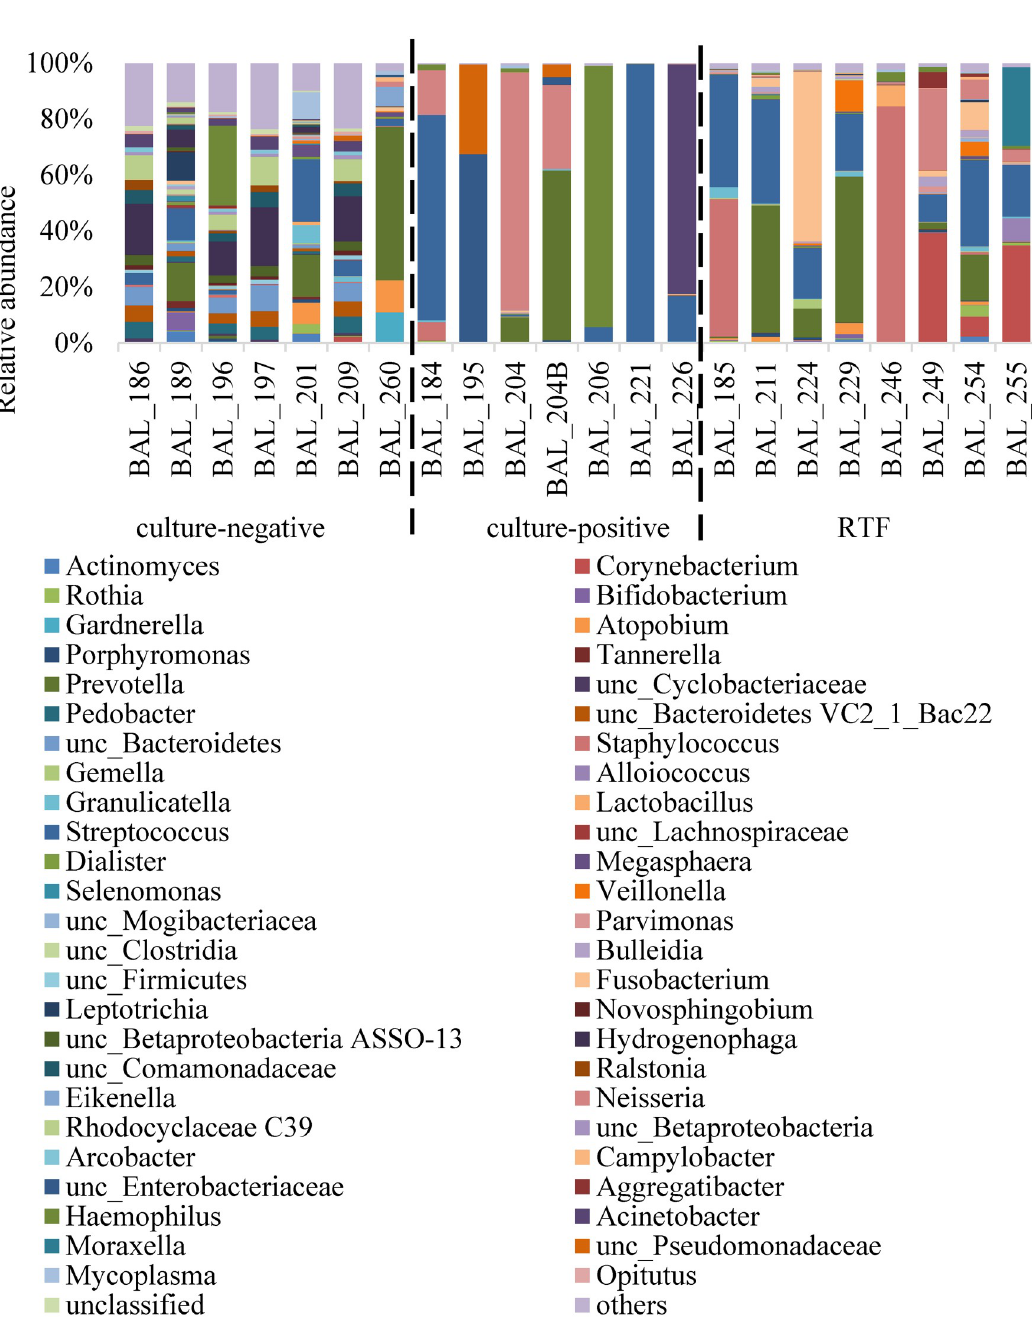
Fig 2. Relative abundance of bacterial genera in culture-negative, culture-positive, and RTF (respiratory tract flora) for bronchoalveolar lavage (BAL) samples. Genus-level taxonomic designations with 2% relative abundance are presented.